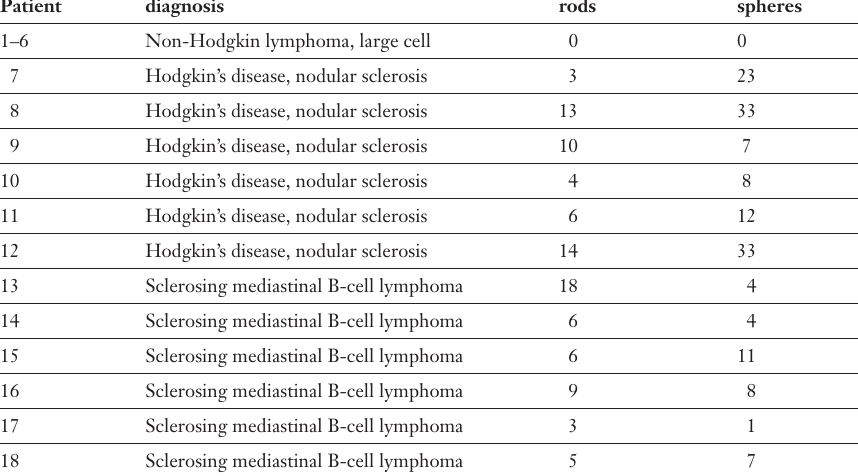
Periodic acid-Schiff (PAS) stained sections of lymph nodes: (A), (B), (C): Hodgkin’s disease ( x 2000). (D): Scleros- ing mediastinal B-cell lymphoma ( x 1000). A:Intracellular rods (arrow). B: Intracellular spheres and rod (arrow). C: Adjacent cells with rods (arrow) and sphere. D:Intracellular rods (arrow).